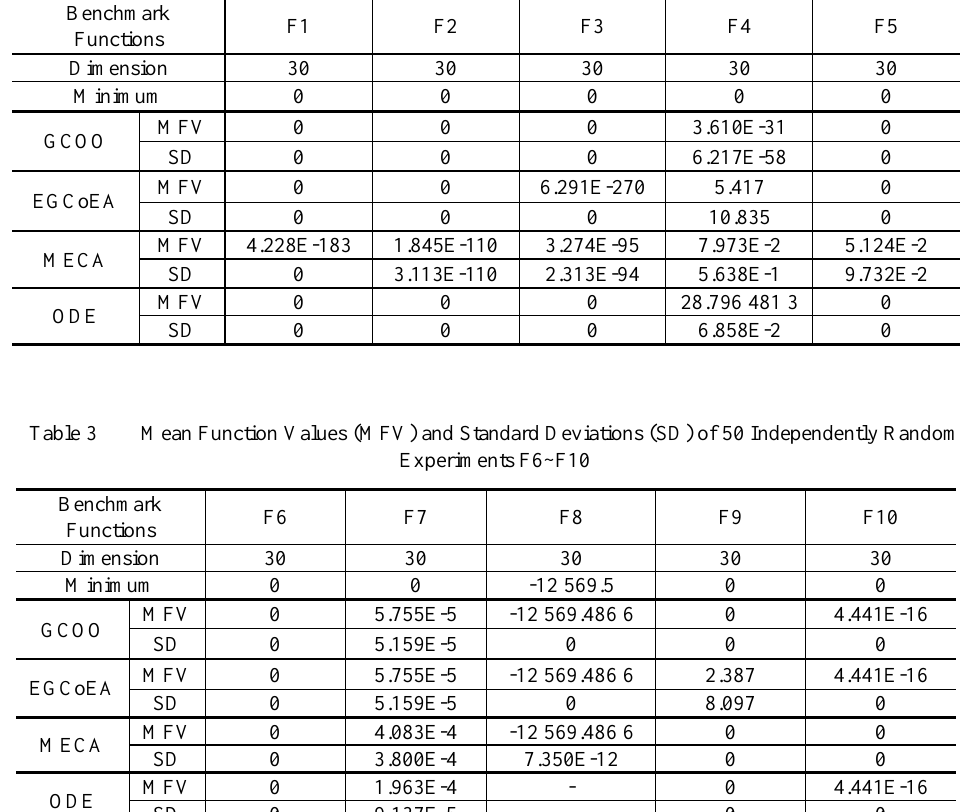
Table 4 Mean Function Values (MFV) and Standard Deviations (SD) of 50 Independently Random